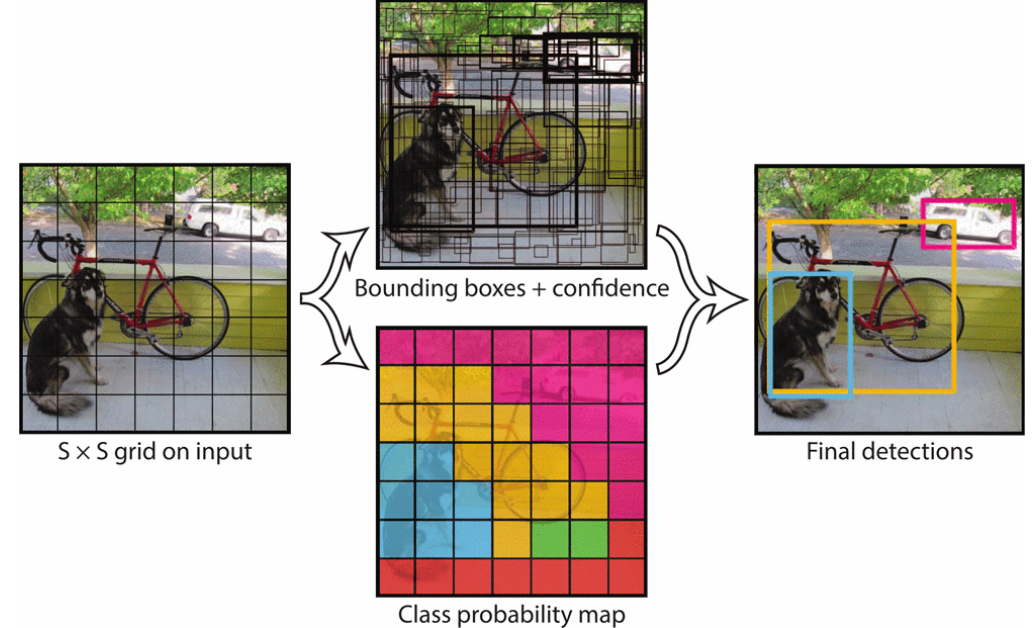
Figure 2. Unified Detection using YOLO taken from Redmon et al. (2016) [43]